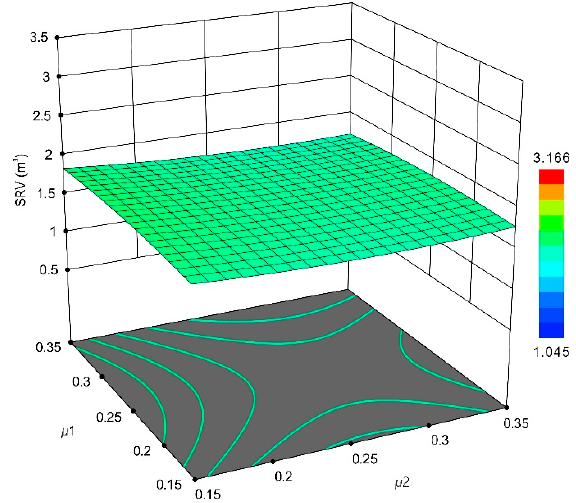
Figure 15. Response surface of the interaction between µ 1 and µ 2 to SRV.